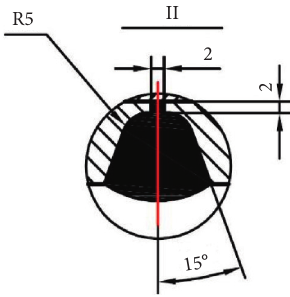
Figure 4: Weld metal.